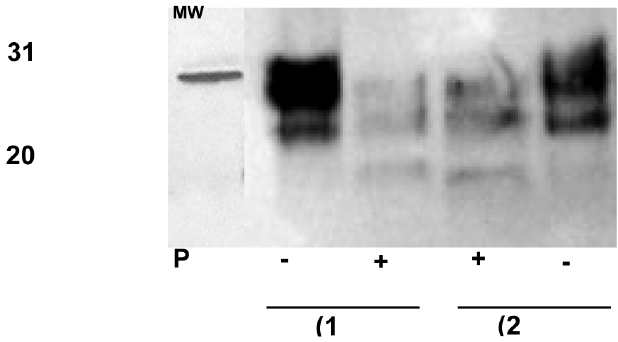
Fig. 3. Western blot analysis showing, in the left column, molecular 31 and 20 Kda markers (MW), a cerebellum extract from a sCJD PrP-type 1 case (1) and the brain biopsy from our patient (2), both without ( − ) and with ( + ) proteinase-K (PK)